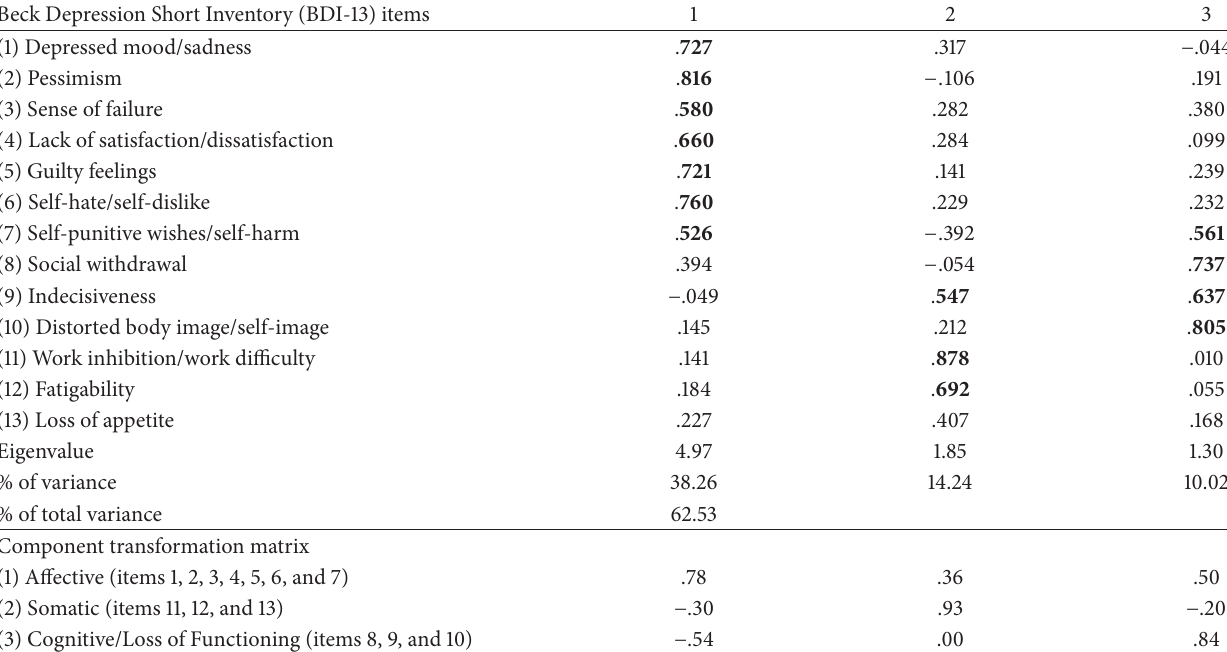
Table 4: Factor loadings of BDI-13 in Iranian psychiatric outpatients ( 𝑁 = 52